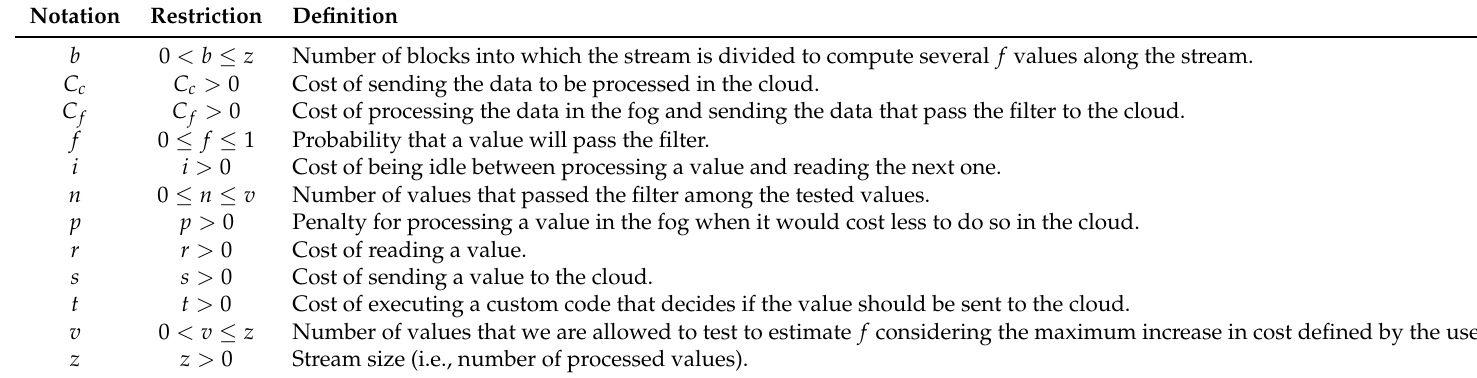
Table A1. Notation for the cloud and fog computing cost